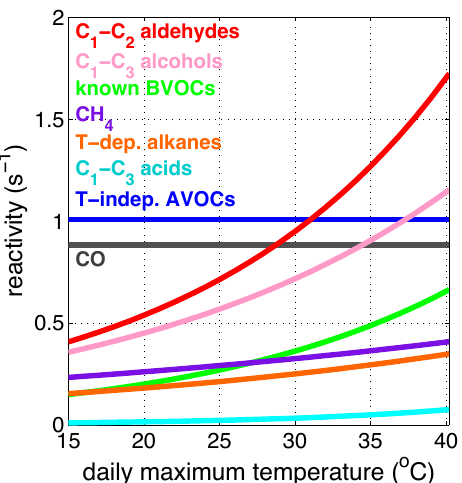
Fig. 1. Empirical fits of the daily average (10:00–14:00LT) 6 i VOCR i (s − 1 ) versus daily maximum temperature ( ◦ C). Data points for each curve are shown in Fig. B1. Colors are as follows: C 1 –C 2 aldehydes (red), C 1 –C 3 alcohols (pink), known biogenic VOCs (green), CH 4 (purple), temperature-dependent alkanes (or- ange), C 1 –C 3 organic acids (cyan), CO (gray), and temperature- independent AVOCs (blue). For a listing of the mean VOCR i of each molecule see Table